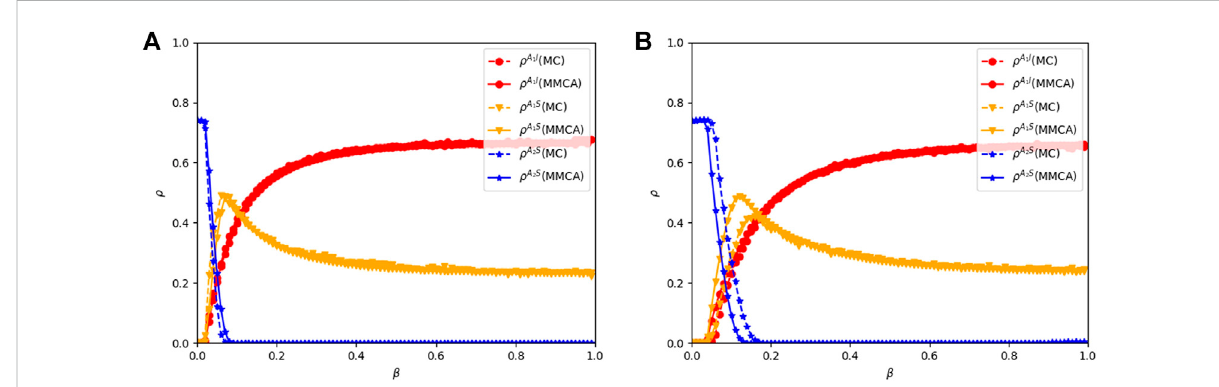
FIGURE 6 Comparison between MMCA and MC simulation. Result shows the proportions of ρ A 1 I , ρ A 1 S , and ρ A 2 S with the increase of β . (A) Networks in the informationandphysicallayersaretheBAandERnetworks,respectively. (B) NetworksintheinformationandphysicallayersarebothERnetworks.All results are averaged by 50